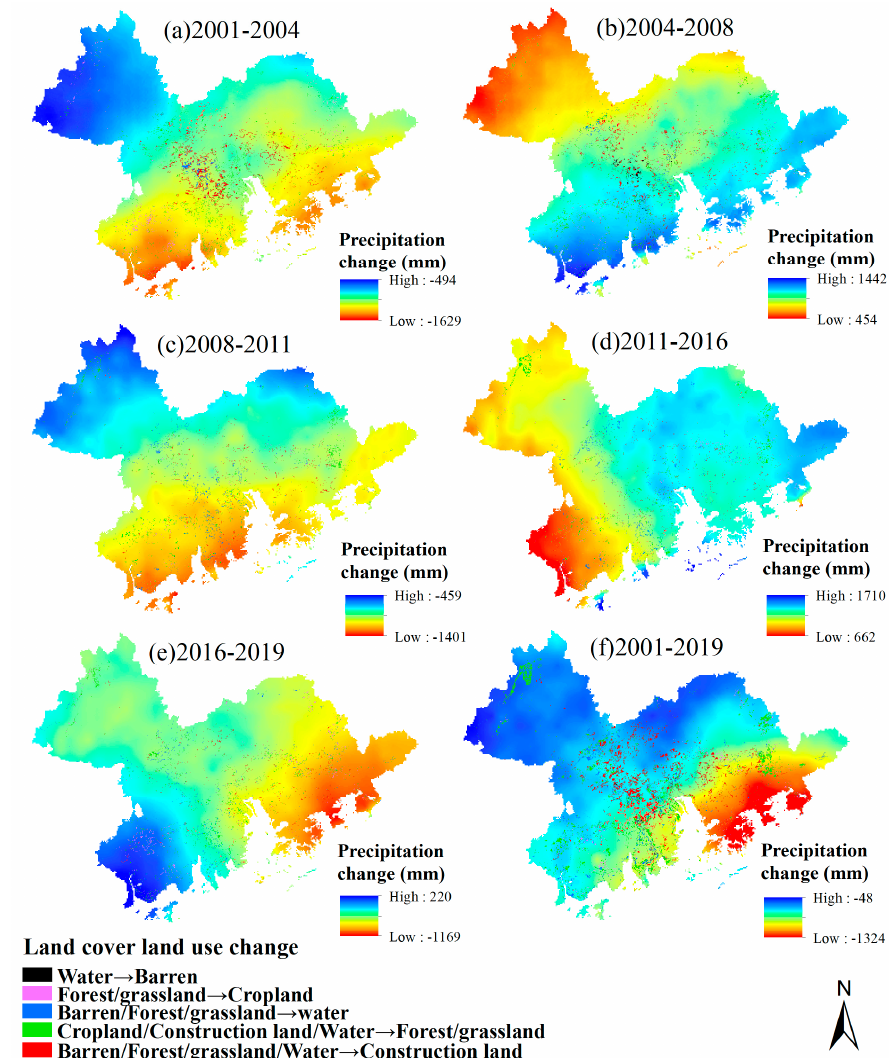
Figure 12. Spatial superposition map of land cover land use change and precipitation change.